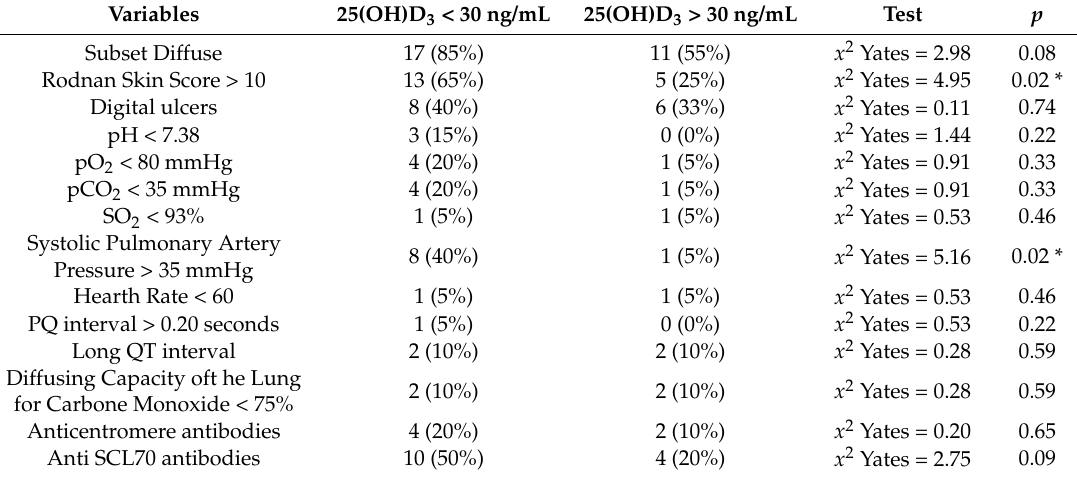
Table 3. Association between 25(OH)D 3 insufficiency and clinical parameters in systemic